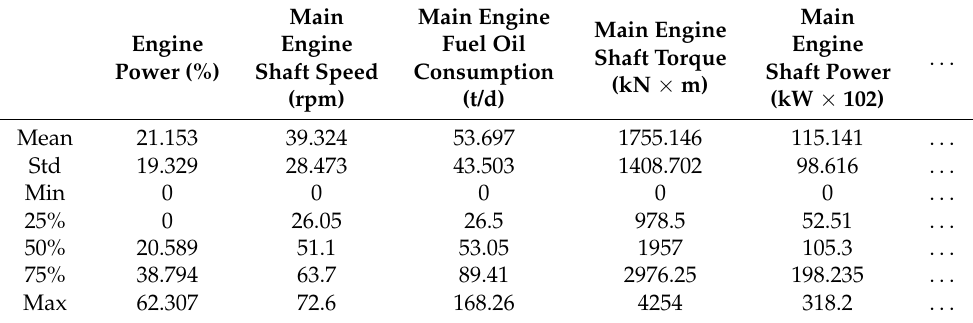
Table 1. Statistical input of the dataset in